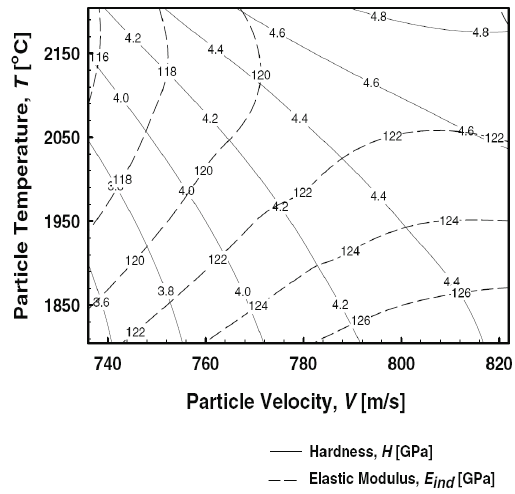
Figure 7. Second-order process maps for HVOF NiCr of elastic modulus and hardness with different particle temperatures and velocities